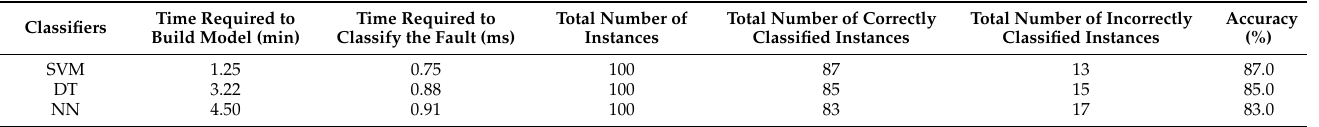
Table 14. Classification accuracy of different classifiers using experimental data with GA.